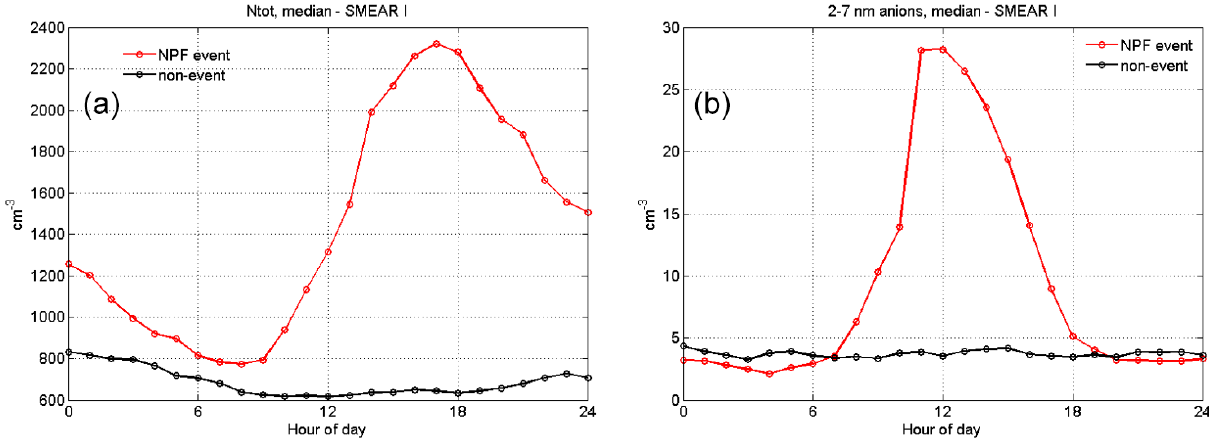
Figure 7. Median (a) total particle concentration ( N tot ) and (b) 2–7nm negative ion concentrations at SMEAR I during NPF event (red, n = 33) and non-event days (black, n = 75). The total particle number concentration is recorded with a CPC, and air ion concentrations are measured with a